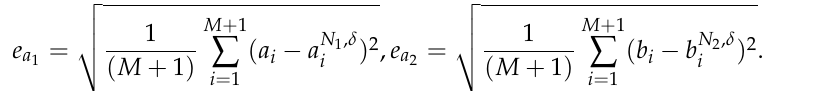
Table 1. Numerical results of Instance 1 for different α with ε = 0.01